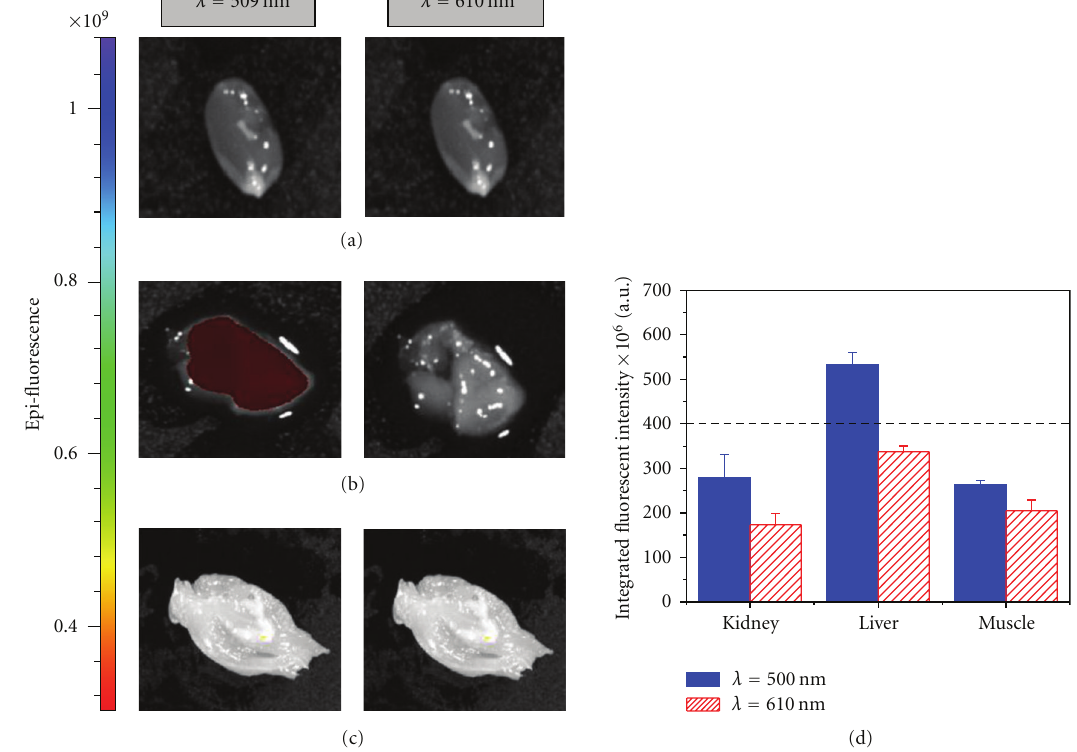
Figure 2: Background signal from normal tissues when excited at 460 nm. There were 2 emission cut-o ff wavelengths: 509 nm and 610 nm. (a) Kidney; (b) liver; (c) muscle; (d) integrated fluorescent intensity depended on the emission cut-o ff wavelength. Dash-line indicates background signal.